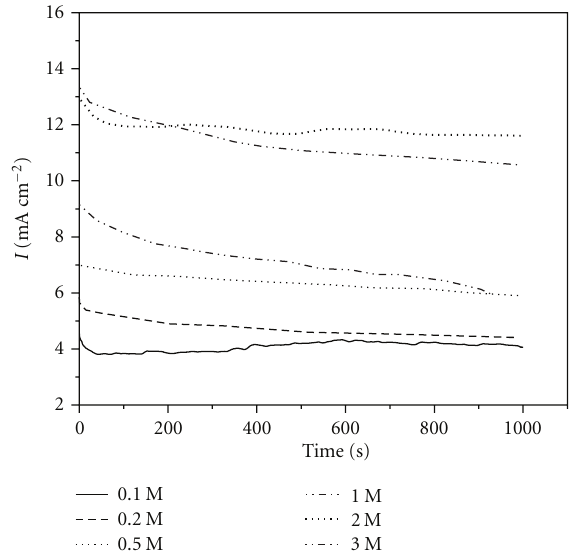
Figure 11: Chronoamperometric curves for methanol oxidation at − 160 mV on Pt-Pd/C catalyst in 0.5 MNaOH containing various concentrations of